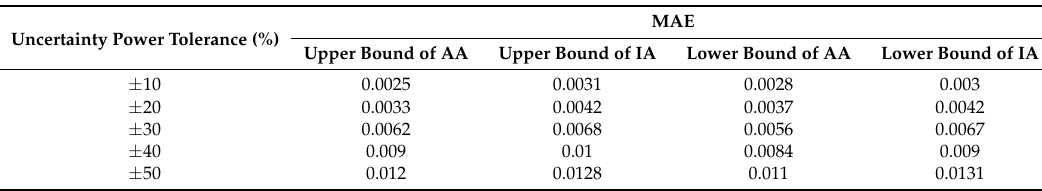
Table 1. MAE analysis under different uncertainty tolerances.